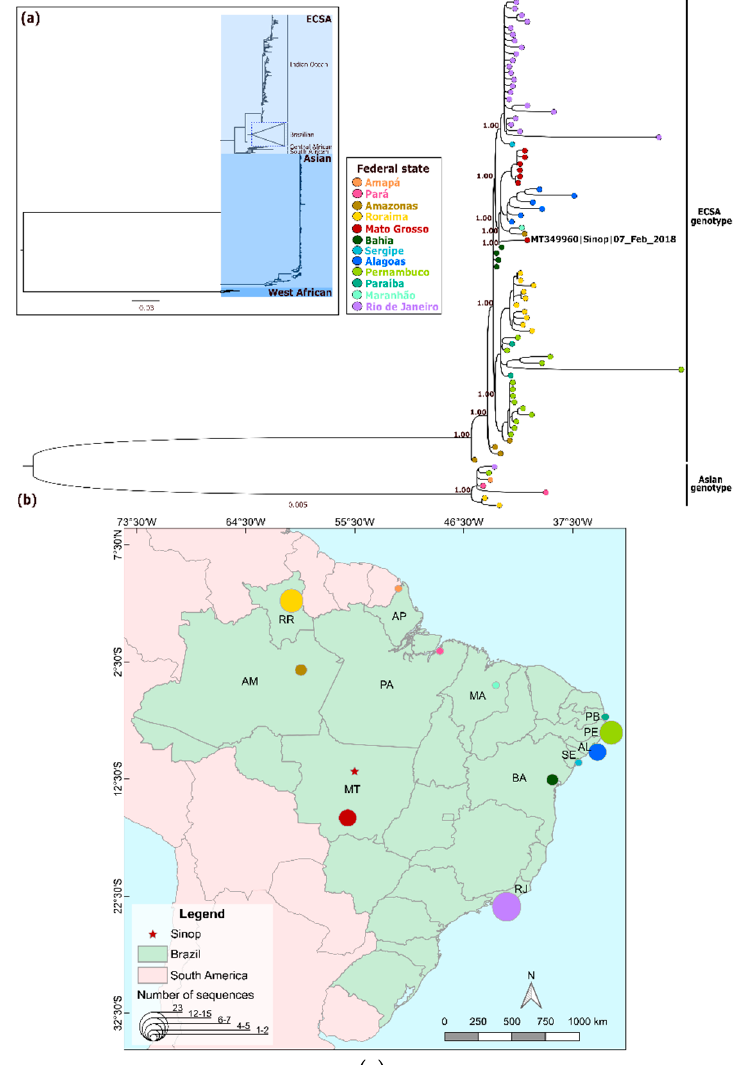
Figure 3. Phylogenetic reconstruction and positioning of CHIKV genome obtained in this study using maximum likelihood. ( a ) Full phylogeny including all available West African, East/Central/South African (ECSA)—Indian Ocean lineages and Asian/Caribbean using complete and draft genomes >8 kb. ( b ) Phylogenetic analysis focusing on Brazilian genomes of a subset of ECSA and Asian/Caribbean CHIKV genomic sequences from the full CHIKV tree. ( c ) Distribution of the number of CHIKV genomes sequenced per state. State colors follow tip colors in panel B.